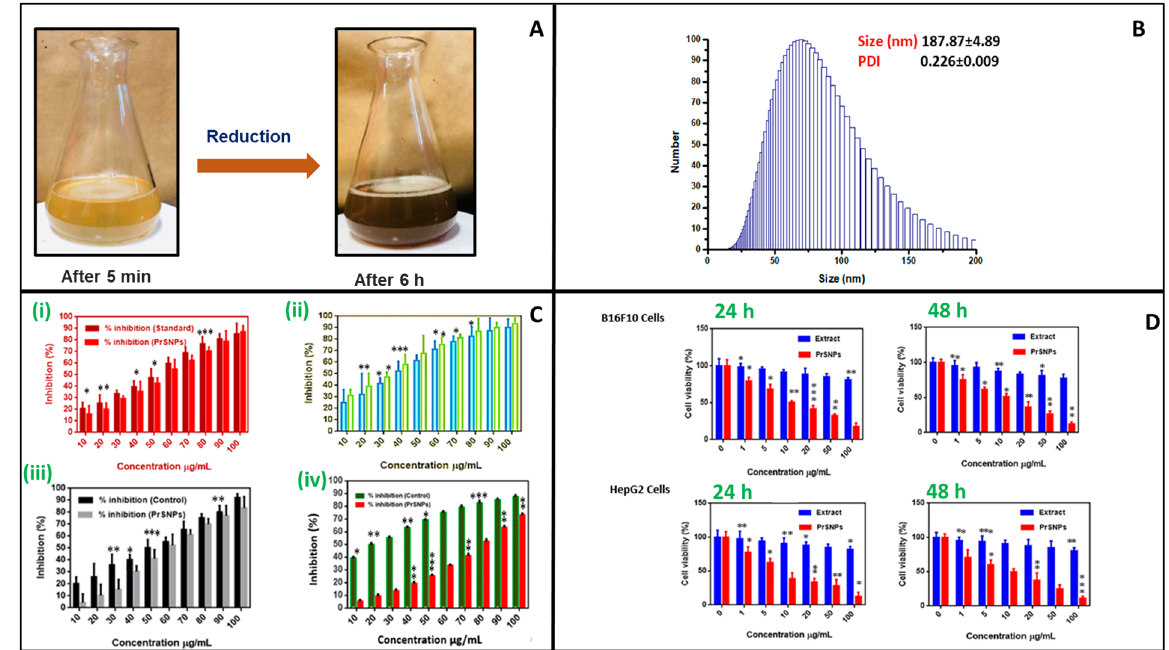
Figure 4. Green synthesis of AgNPs using leaf extract of P. hysterophorus . ( A ) The reduction of AgNO 3 by P. hysterophorus extract indicated a color change after 5 min and 6 h. ( B ) Particle size distribution. ( C ) Anti-inflammatory activity of AgNPs according to (i) DPPH assay, (ii) H 2 O 2 assay, (iii) NO free radical-scavenging assay, and (iv) nitric oxide radical-scavenging assay. ( D ) In vitro cytotoxicity test on B16F10 and HepG2 cell lines after 24 h and 48 h treatment; * p < 0.05, ** p < 0.01 and *** p < 0.001, unpaired Student’s t -test. CC-BY License [86].